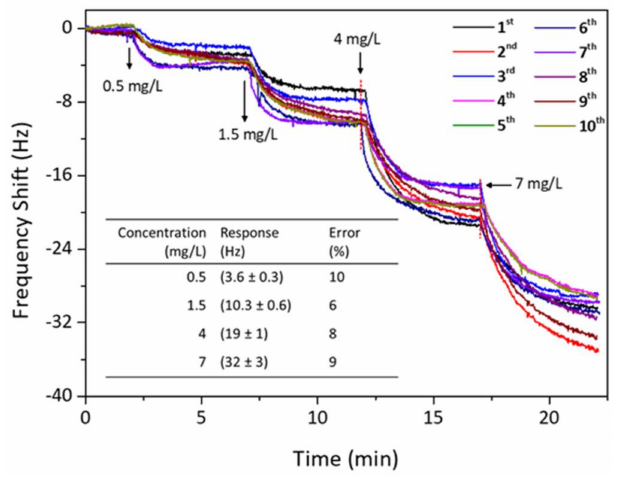
Figure 7. Reversibility testing for PAN-NF 4 nanofiber QCM sensors upon exposure to increasing the safrole concentrations. (Inset: systematic error of PAN-NF 4 sensor from 10-time measurement; the response is taken at t = 5 min after each